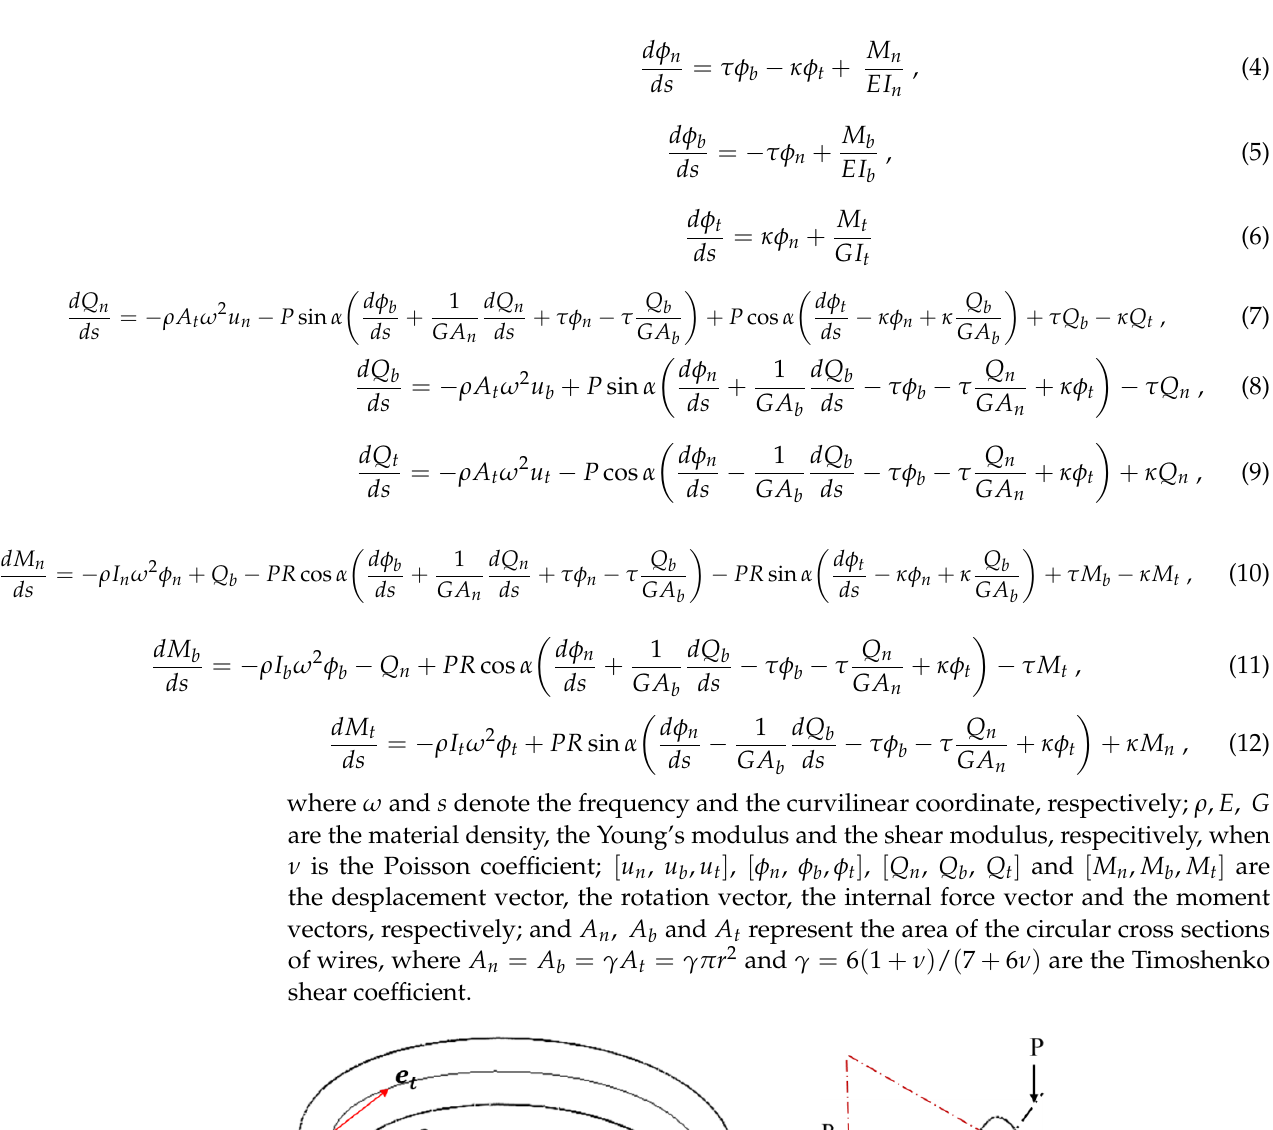
assumed as a combination of a finite number of short curved